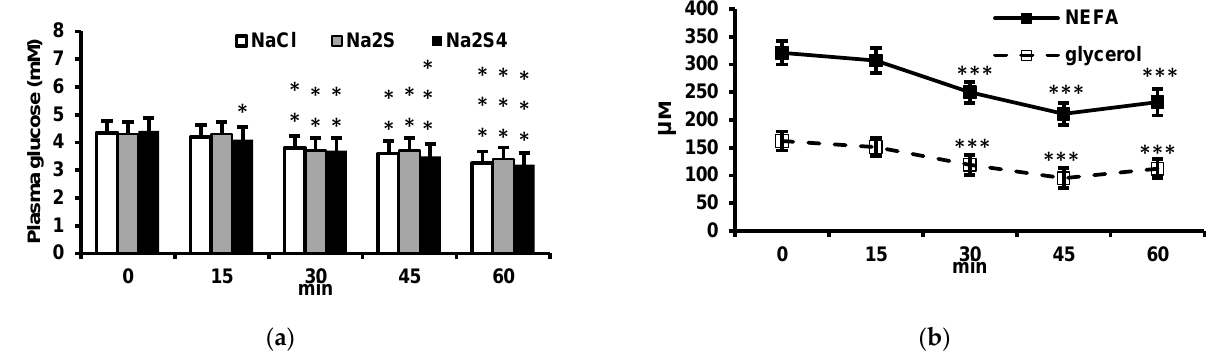
Figure 2. ( a ) Effect of insulin on plasma glucose concentration. Insulin was injected intraperitoneally at 0.5 U/kg and glucose was measured after 15, 30, 45 and 60 min. Rats received 0.5 ml 0.9% NaCl, 100 μmol Na 2 S or 100 μmol Na 2 S 4 intravenously 15 min before insulin. ( b ) Effect of insulin on plasma NEFA and glycerol at different time points after injection. * p < 0.05, ** p < 0.01, *** p < 0.001 vs. baseline value in the respective group (repeated-measures ANOVA).